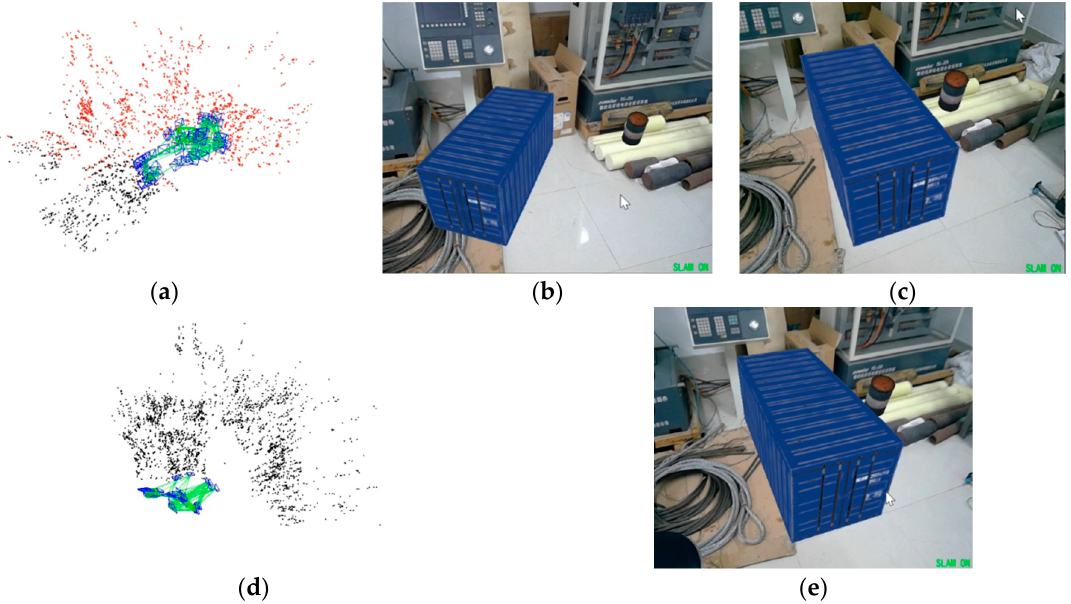
Figure 14. AR registration based on SLAM map reloading: ( a ) SLAM map in online positioning mode; ( b ) 3D model of initial placement; ( c ) 3D model after rotation, translation, and scaling; ( d ) SLAM map in offline positioning mode; ( e ) 3D model after loading the map.